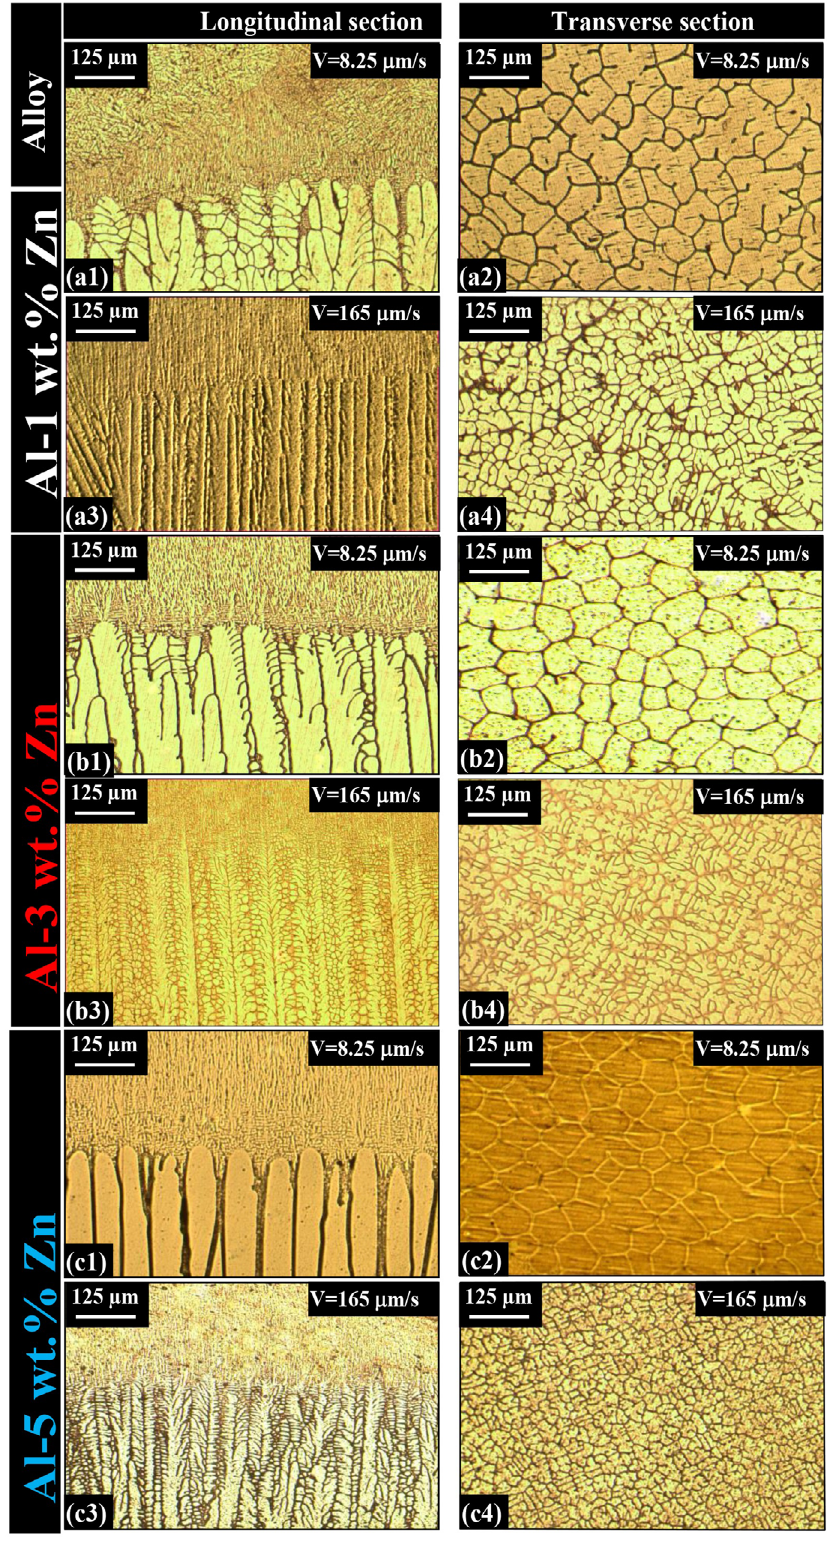
Figure 4. The growth morphologies of the directionally solidified Al-(1, 3, 5) wt.% Zn alloy for the lowest and the highest growth velocities (a1-a4) Al-1 wt.% Zn, (b1-b4) Al-3 wt.% Zn, (c1-c4) Al-5 wt.%